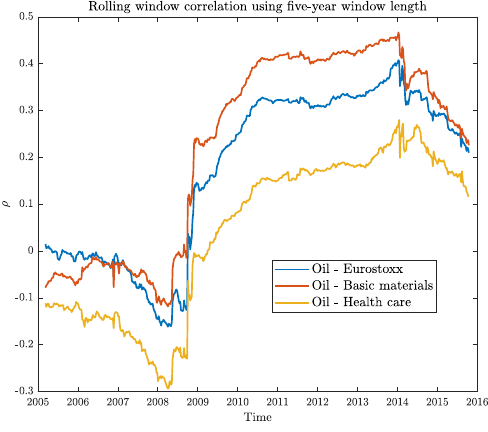
Figure 1: Time-varying correlation between stock returns and oil returns. This figures shows the evolution of the correlation between oil and Eurostoxx (blue line), basic materials (red line) and health care (yellow line). The correlation evolves over time using a rolling window on weekly returns with a five-year window length, i.e. at each time t I assess the correlation of the weekly returns between t − 260 and t . The figures depict two evidences. First, the lower correlation between health care and oil than other stock returns. Second, the shift in the correlation after 2008-2009, which might indicate the presence of a regime switch.